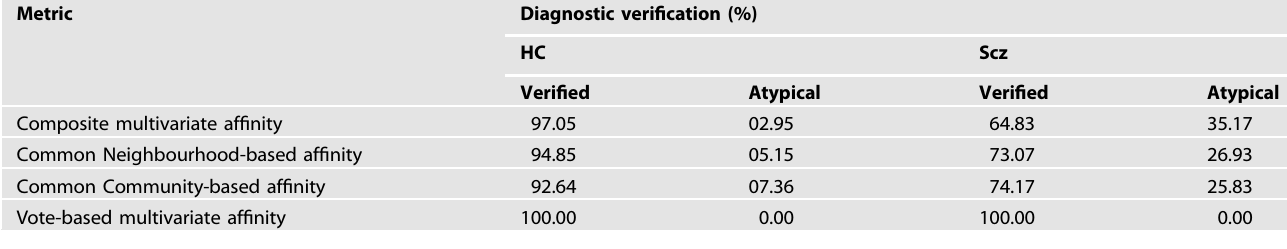
Table 3. Performance evaluation of af fi nity-based diagnostic veri fi cation framework across two diagnostic groups.